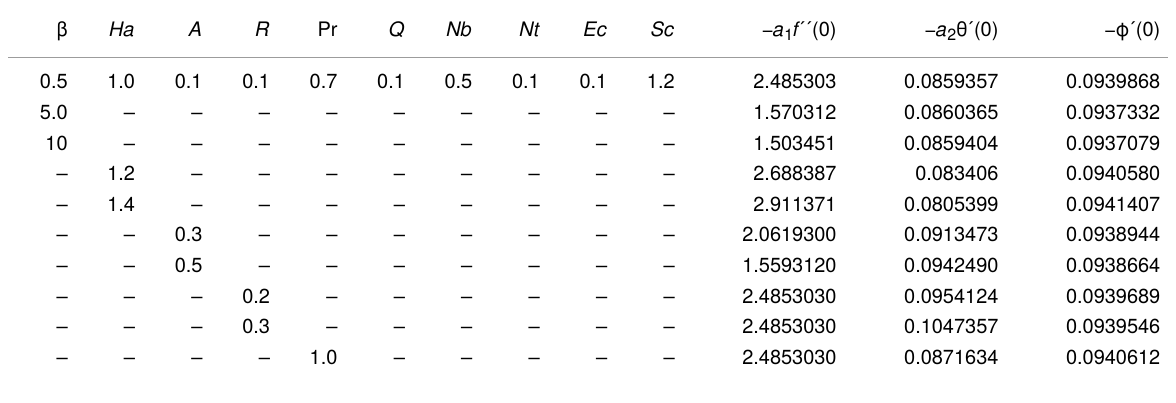
Table 4: The computed results for the skin-friction coefficient, Nusselt and Sherwood numbers, for γ = 1, Bi 1 = 0.1 = Bi 2, where a 1 = (1 + 1/ β ) and a 2 = (1 + 4/3· R ).